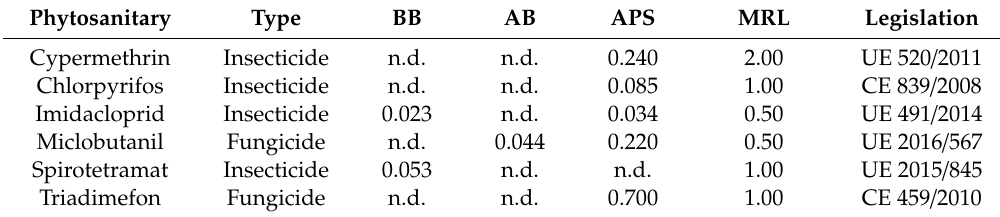
MRL: Maximum Residue Limit; n.d.: Not